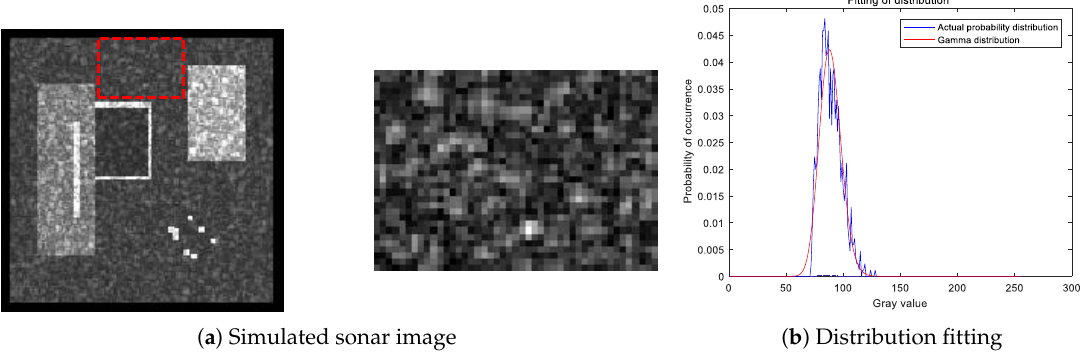
Figure 3. Statistical distribution and fitting for the simulated sonar image